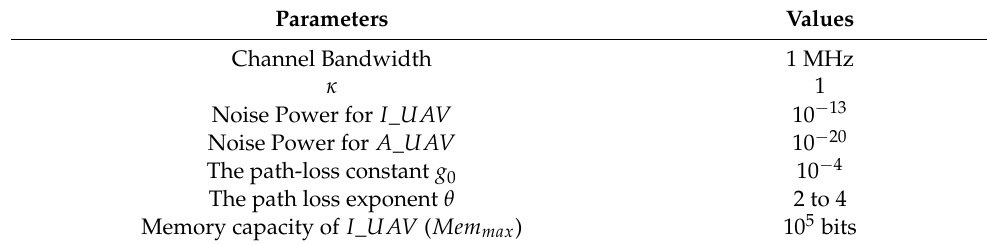
Table 2. List of Simulation